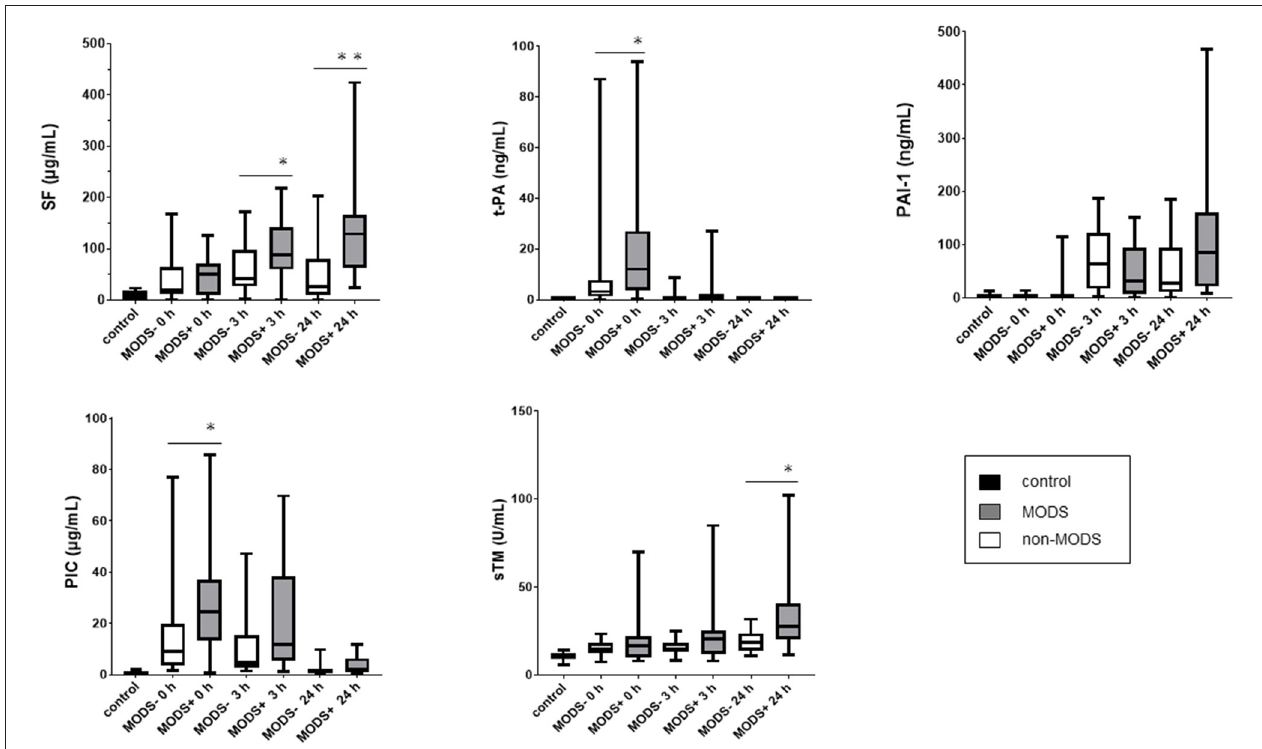
FIGURE 2 | The serial changes of coagulofibrinolytic molecular makers in the MODS and non-MODS groups. * p < 0.05, ** p < 0.01. MODS, multiple organ dysfunction syndrome; PAI-1, plasminogen activator inhibitor-1; PIC, plasmin-alpha 2-plasmin inhibitor complex; SF, soluble fibrin; sTM, soluble thrombomodulin; t-PA, tissue-type plasminogen activator.